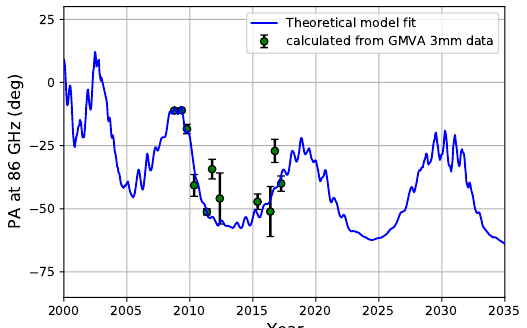
Figure 9. The position angle of the radio jet in 86 GHz observations (points) compared with the model line. The best-fit parameters are taken from Table 1 of Dey et al. [75] and we have used the disk model to calculate the theoretical model line. The viewing angle varies with time but is typically similar to the value found in Hovatta et al. [101]. The delay time between the change of the jet direction at its origin and the appearance of the change in 86 GHz observations is 3.4 yr.